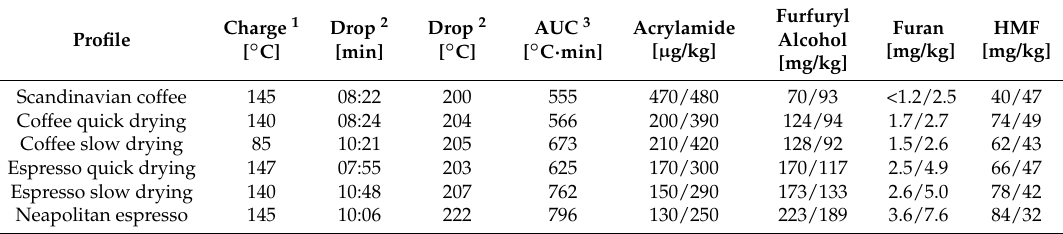
Table 1. Indicators of roasting (data for C. canephora roast; C. arabica data similar) and analytical results of roasted coffee ( C. arabica / C. canephora ).